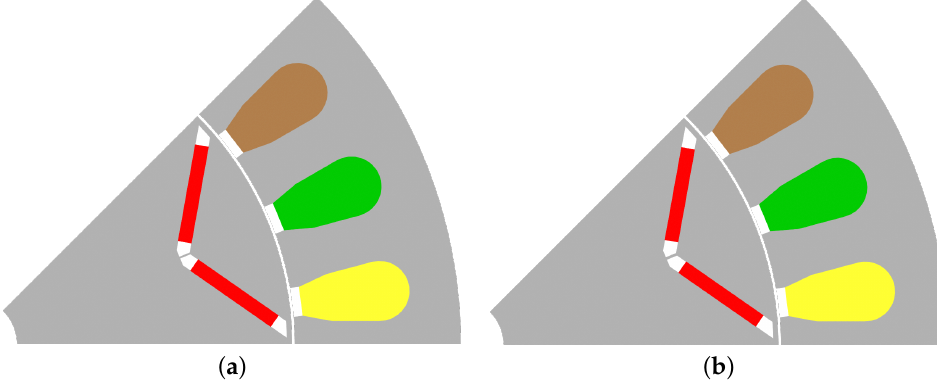
Figure 19. Cross-section of optimum designs from ( a ) multi-point method and ( b ) flux map method, all with eight ECG